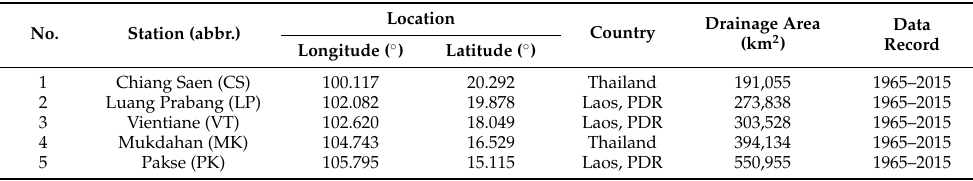
Table 1. The five hydrological gauging